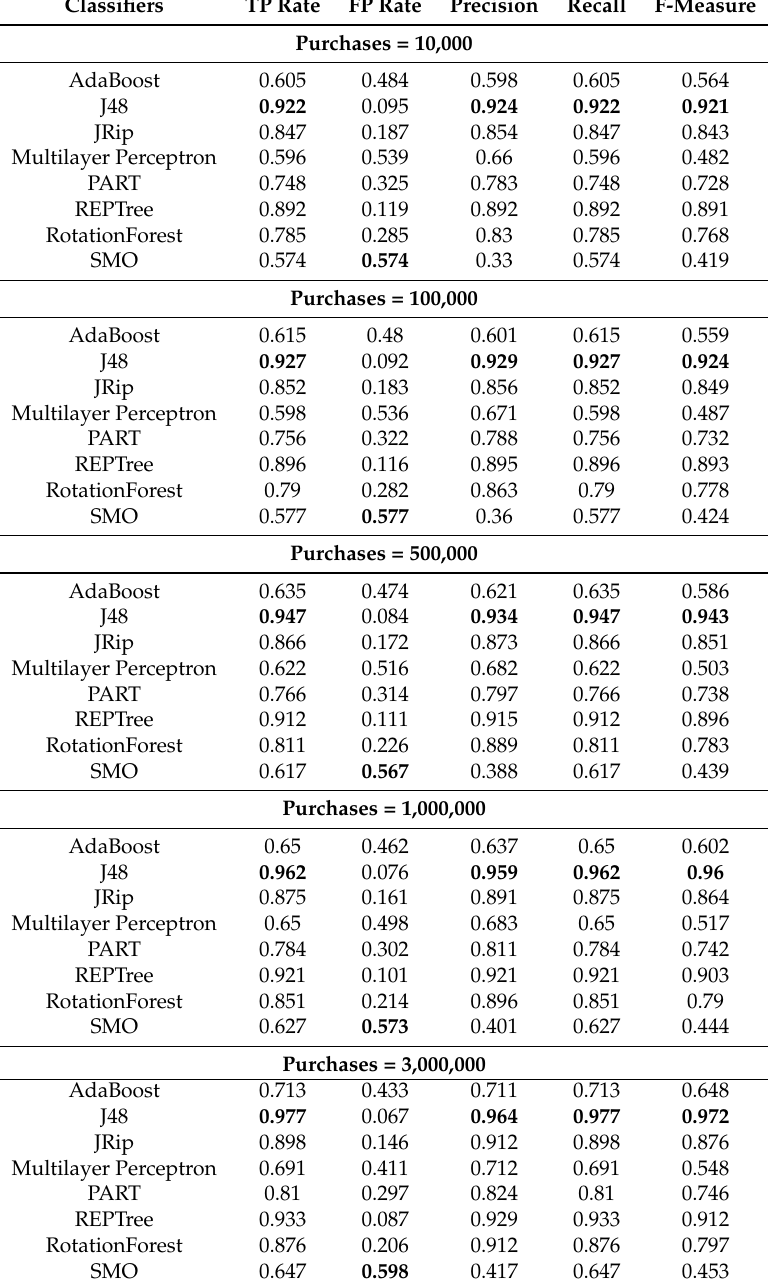
Table 3. Classification for predicting new purchases for different number of randomly selected